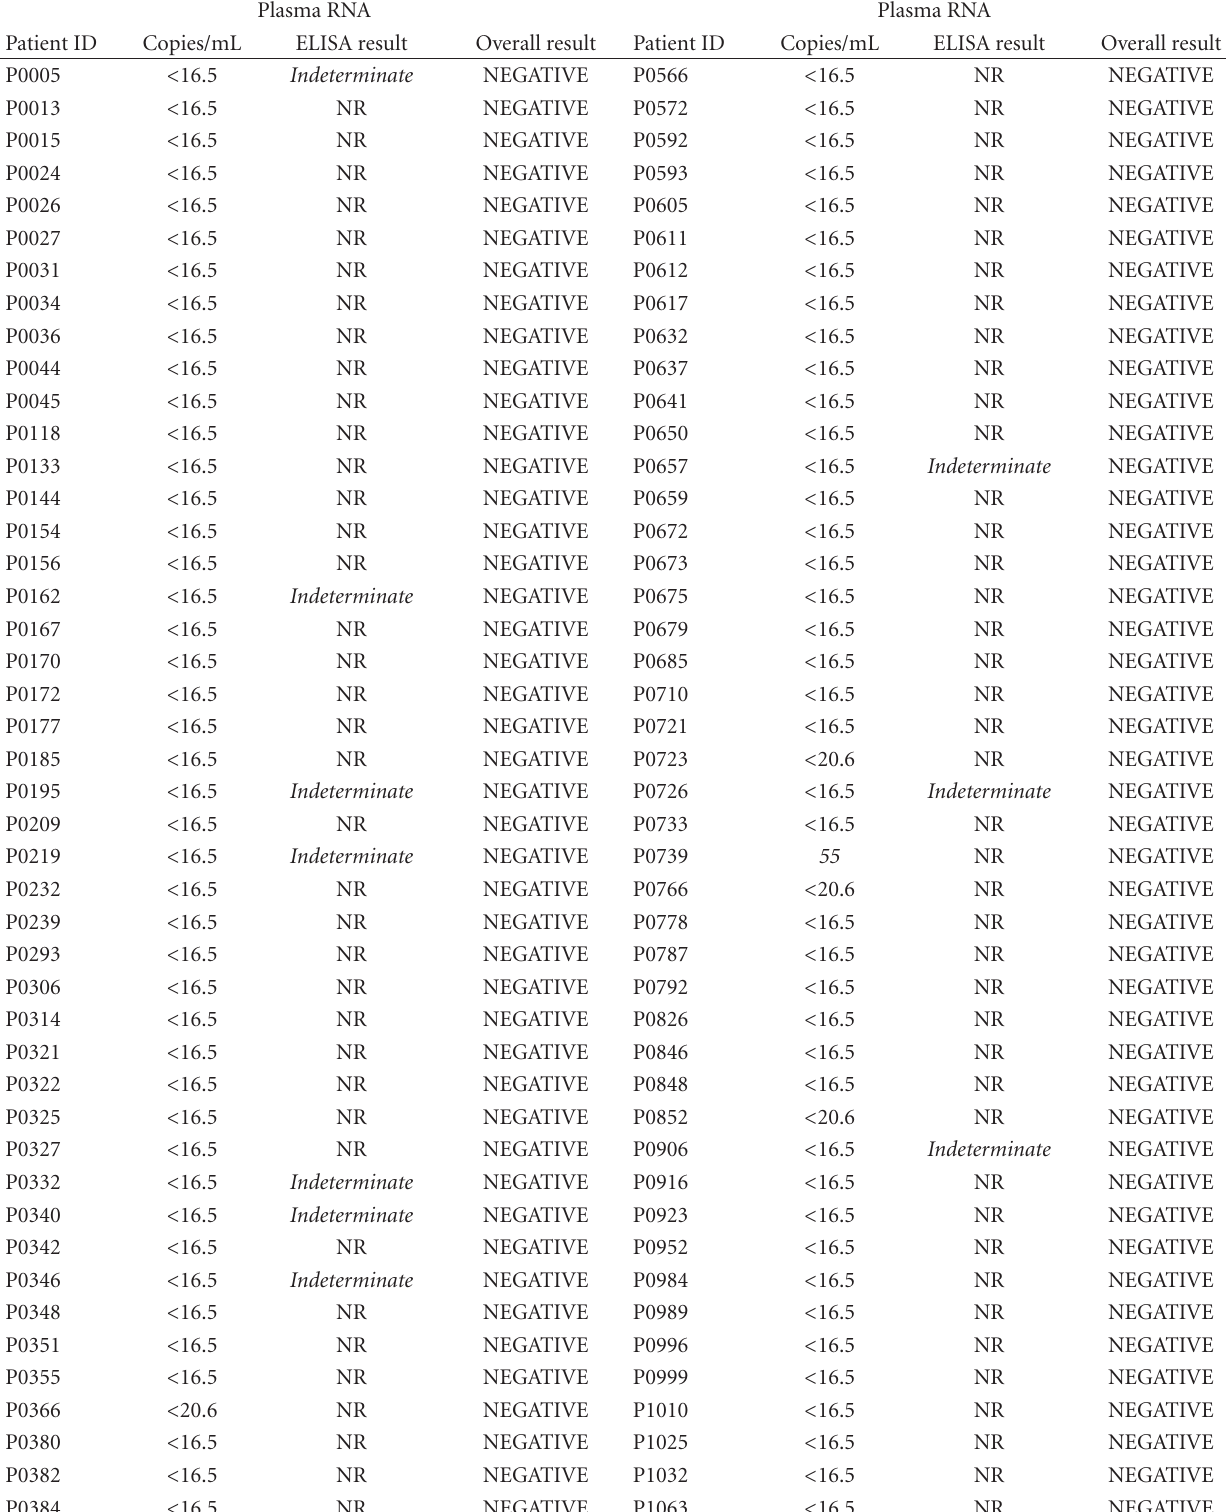
Table 4: X-SCA and ELISA results on prostate cancer samples from UC-Davis cohort. Plasma RNA Plasma